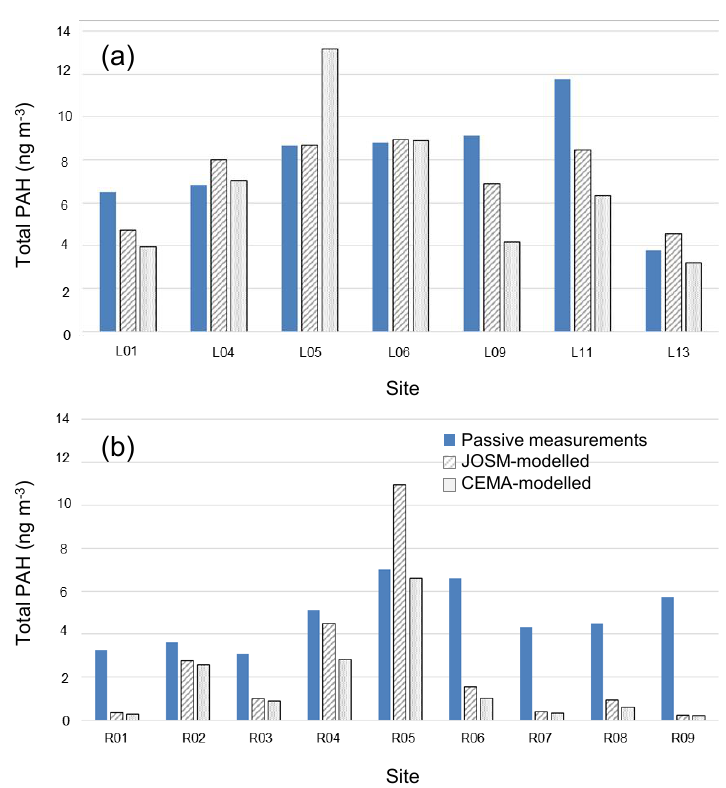
Figure 1. Average total PAH concentrations (excluding NAPH) from November 2010 to June 2012 at local (a) and remote sites (b) for passive measurements, JOSM-modelled case, and CEMA-modelled